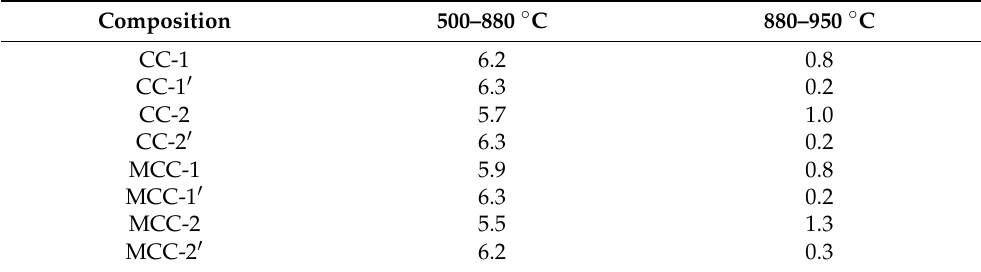
Table 4. The mass loss (%) at different temperature ranges.